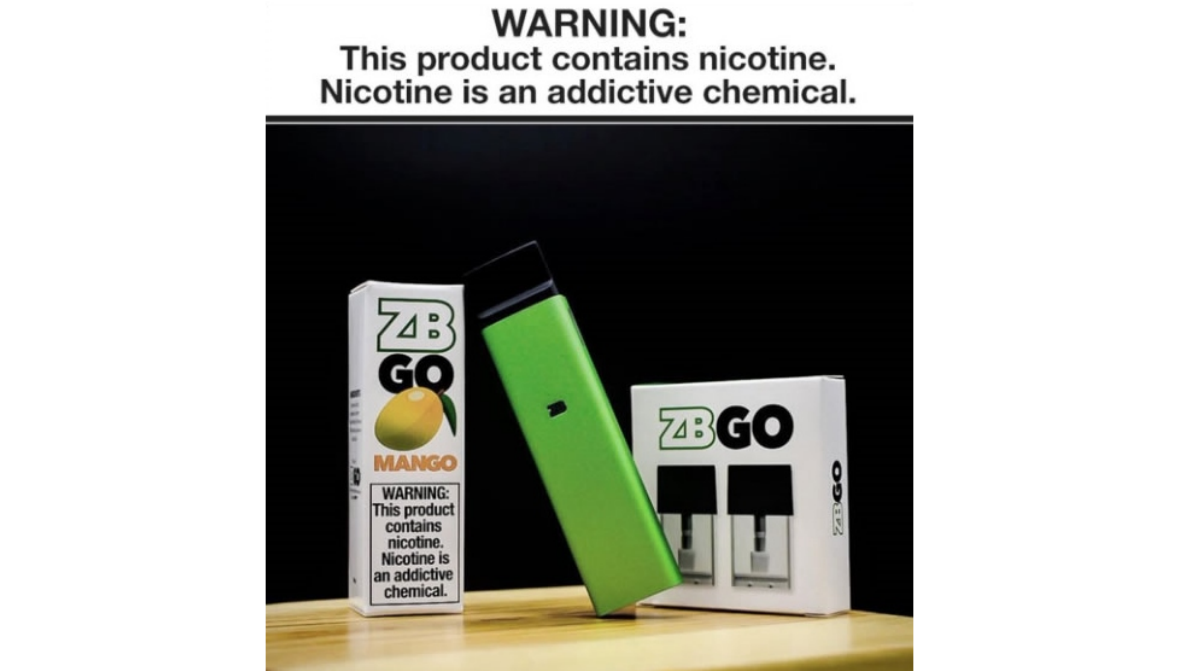
Figure 7. Example of a health warning within the “health, safety, and product claims” domain.